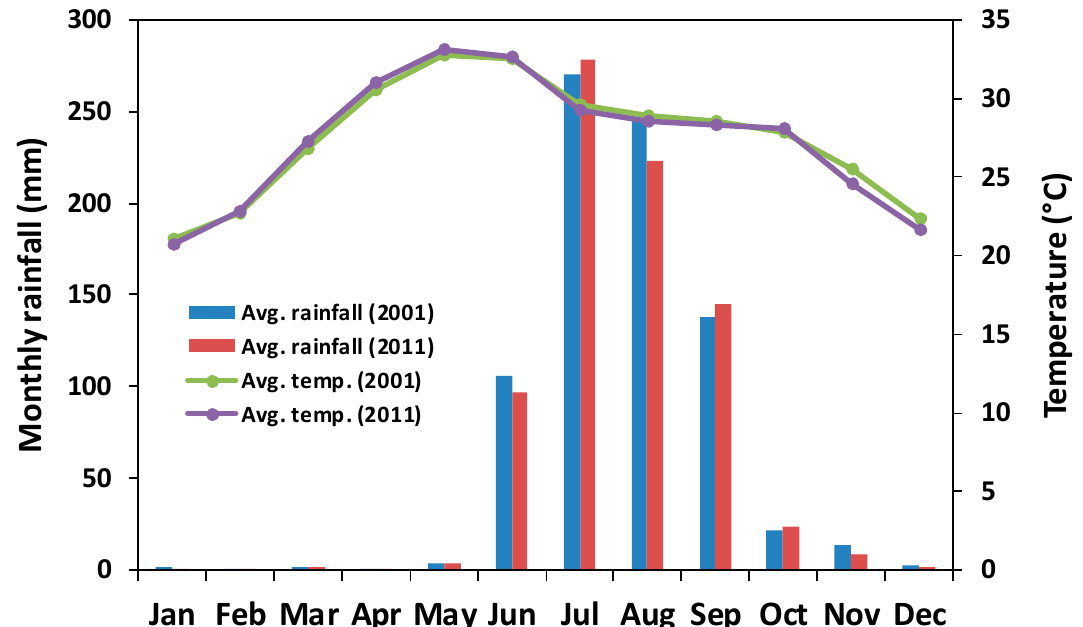
Figure 2. Monthly average rainfall and temperature for the study area in 2001 and 2011.